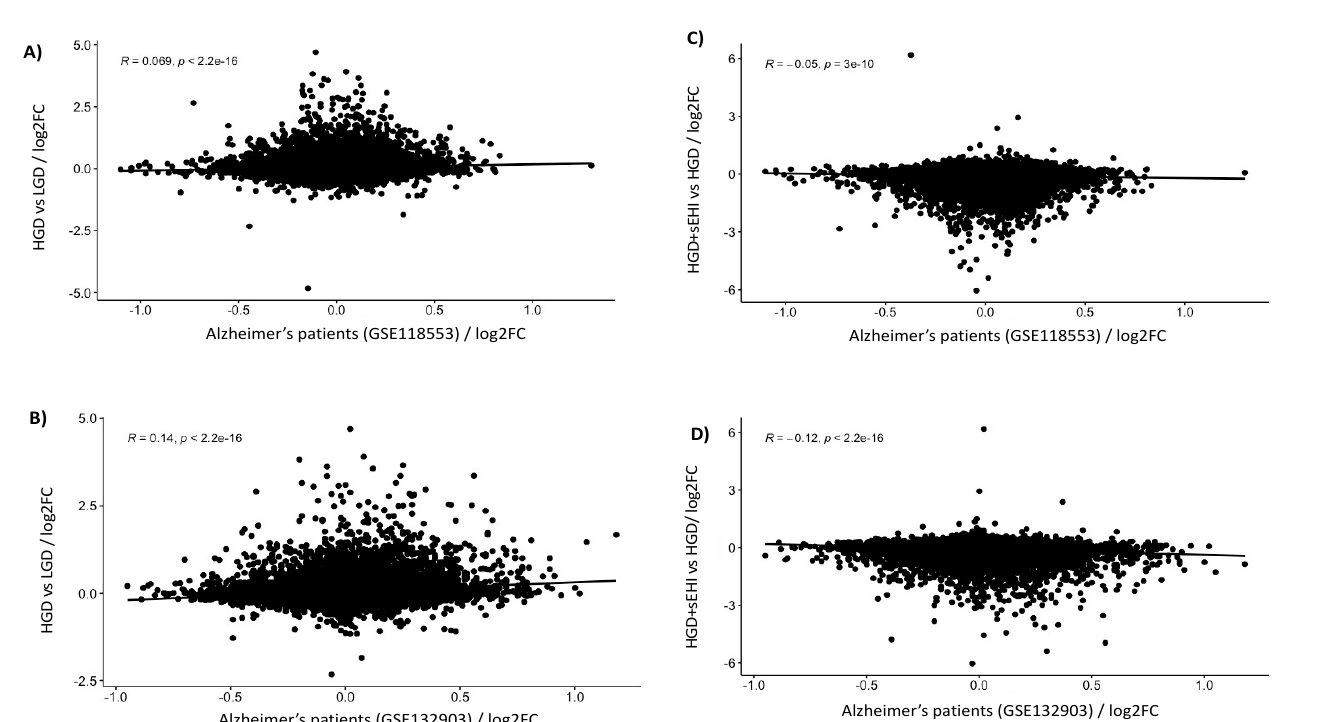
Figure 9. Correlation of the high glycemic diet (HGD) with and without inhibitor to Alzheimer’s disease. Pearson correlation analysis between the genes modulated by the HGD vs LGD and the gene expression profiles observed in patients with Alzheimer’s disease extracted from GEO database number ( A ) GSE118553 and ( B ) GSE132903 . Correlation between genes modulated by the HGD+sEHI vs LGD and patients with Alzheimer’s disease extracted from GEO database number ( C ) GSE118553 and ( D ) GSE132903